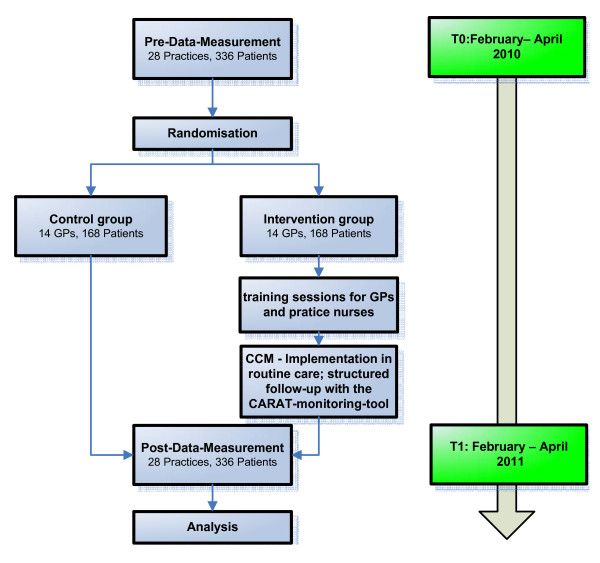
Flow chart of the study.